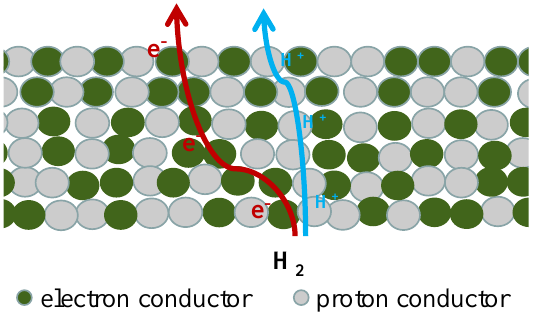
Figure 1. Schematic diagram of the bulk diffusion of protons through the membrane [17]. For single-phase MPEC membranes, the relatively low electronic conductivity limits their hydrogen permeability. In dual-phase membranes, proton conductor is combined with electronic conductors with high electronic conductivity, and separate transport channels for protons and electrons are formed inside the membrane (Figure 2). Therefore, compared with single-phase membranes, dual-phase membranes are expected to have higher ambipolar conductivity and higher hydrogen permeability.